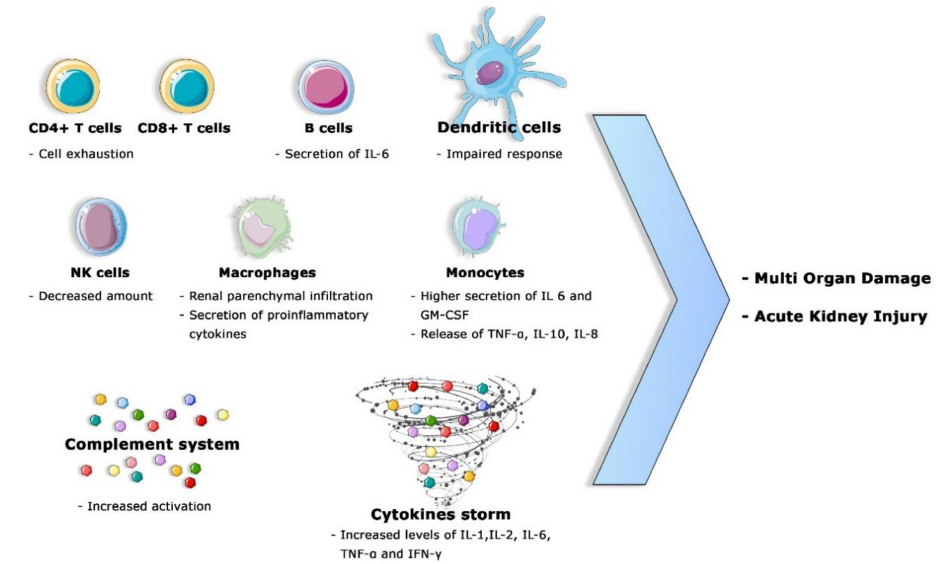
Figure 3. Principal mechanisms of dysfunctional immune response associated with multi-organ damage and AKI. The most important are T cell exhaustion, a decreased amount of NK, dysfunctional B cell activation, impaired DC response, the higher activation of circulating monocytes, the infiltration of macrophages into the renal parenchyma, the higher secretion of pro-inflammatory cytokines (cytokine storm) and systemic complement